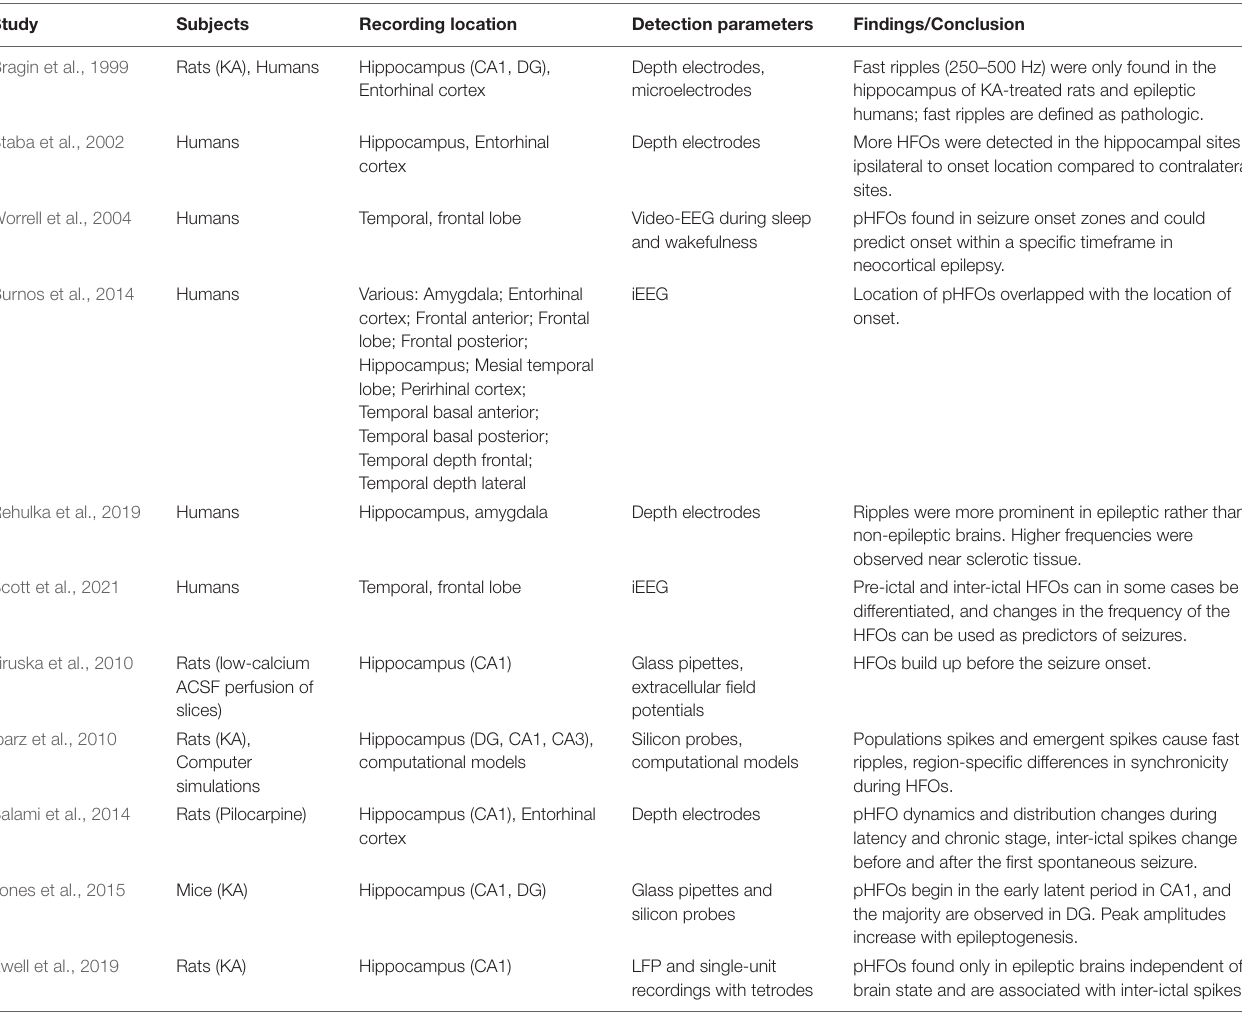
TABLE 1 | Studies evaluating pathological HFOs (pHFOs) in the epileptogenic